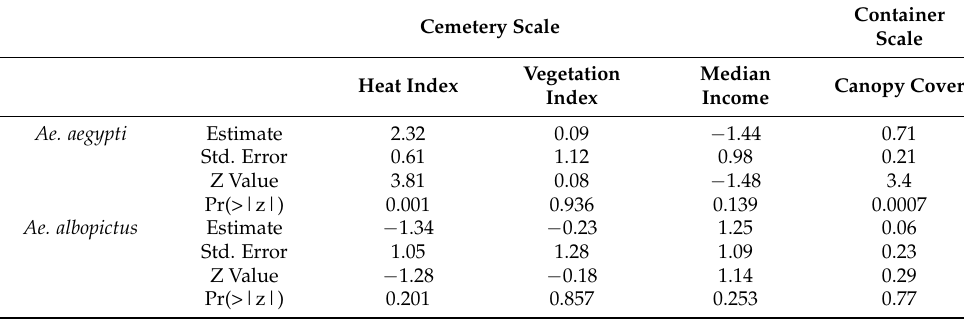
Table 4. Generalized linear mixed effects models for cemetery scale and container scale